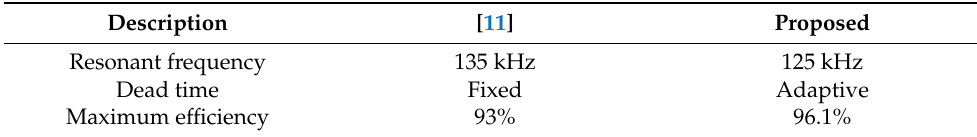
Figure 12. The relation curve between dead-time and efficiency. Table 4. The proposed method compared with the other